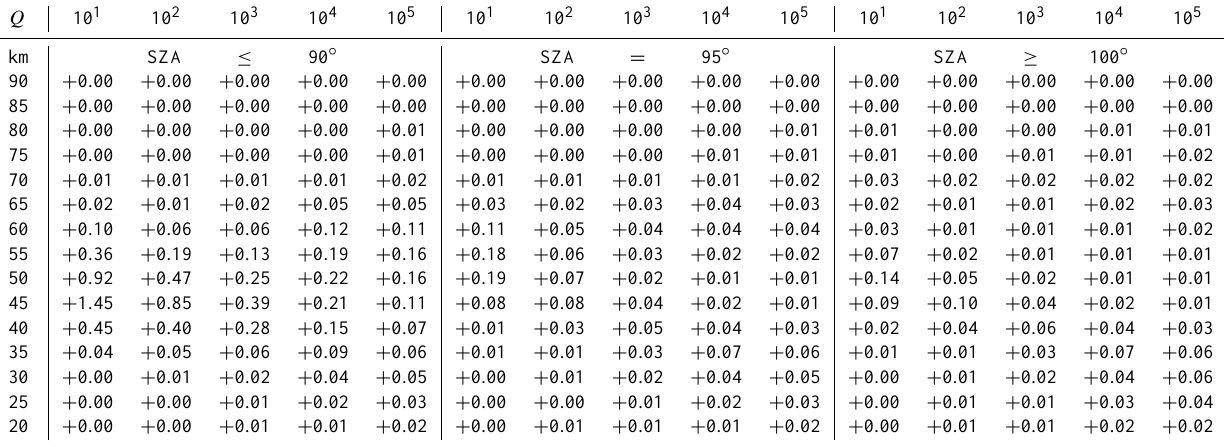
/Q for January SH. 3